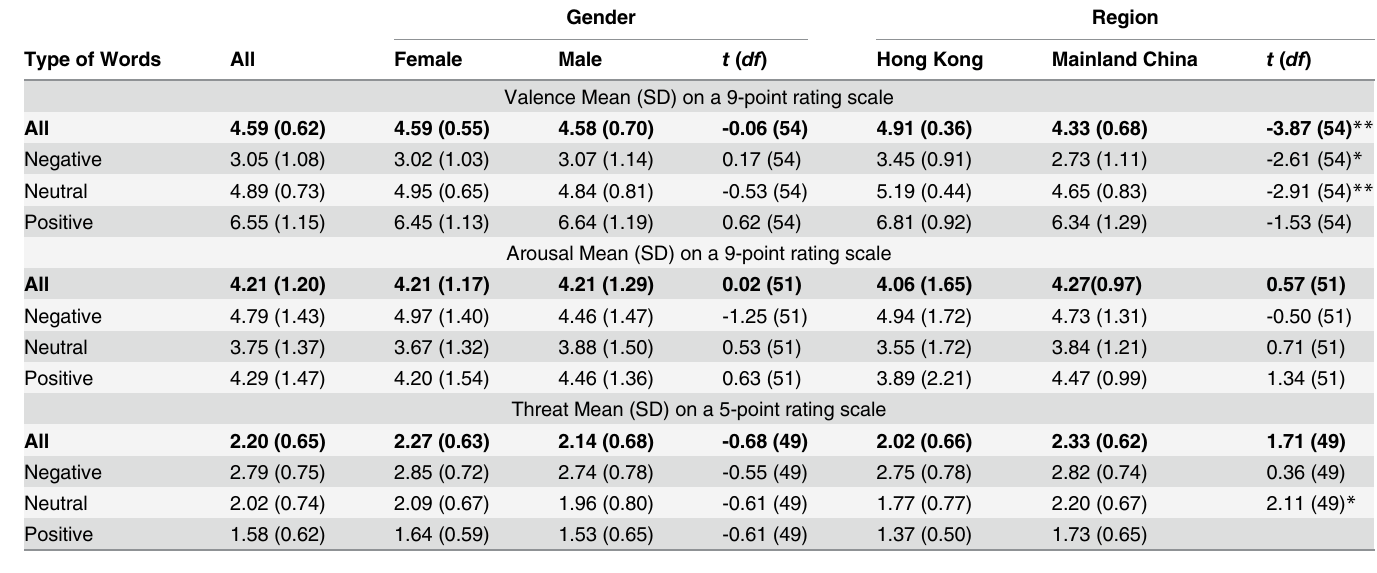
Table 5. Mean (Standard Deviation) for Valence, Arousal, and Threat Ratings by Gender, and Region (number of words = 160).